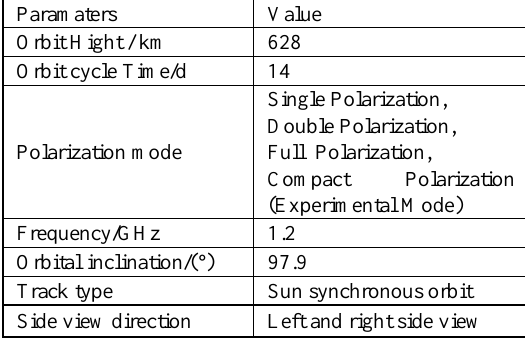
Table 1. ALOS-2 PALSAR Related Parameters